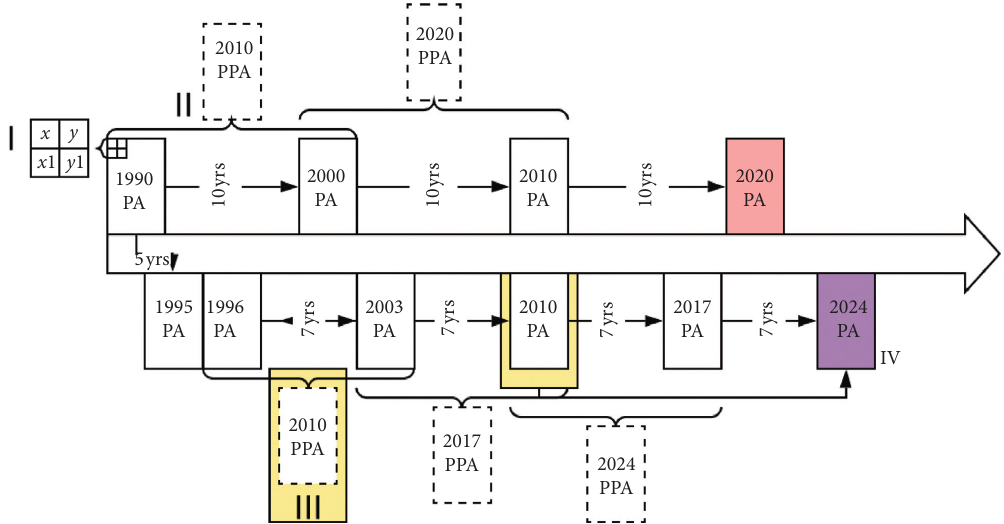
Figure 8: Illustrated flow of the SMA forecasting model on LULC imagery.